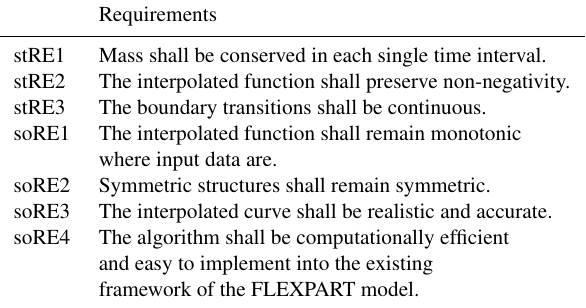
Table 2. Classification of requirements for the interpolation algo- rithm. They are classified into strict requirements (stRE), which are essential and need to be fulfilled, and soft requirements (soRE), which are desirable but not absolutely